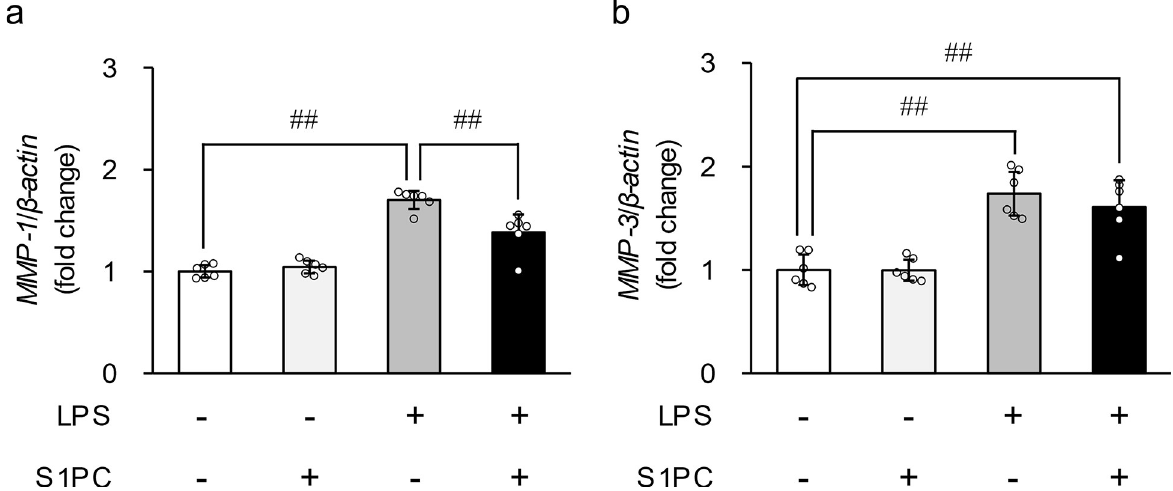
Fig 1. The effect of S-1-propenyl-L-cysteine (S1PC) on the lipopolysaccharide (LPS)-induced gene expression of matrix metalloproteinase (MMP)-1 and -3. HGF-1 cells were exposed to S1PC (300 μ M) in the presence or absence of LPS (3 μ g/mL) for 48 h. Bar graphs show the mRNA level of MMP-1 and -3, calculated relative to the level in each vehicle group. Values represent the mean ± S.D. (n = 5). ## p < 0.01.